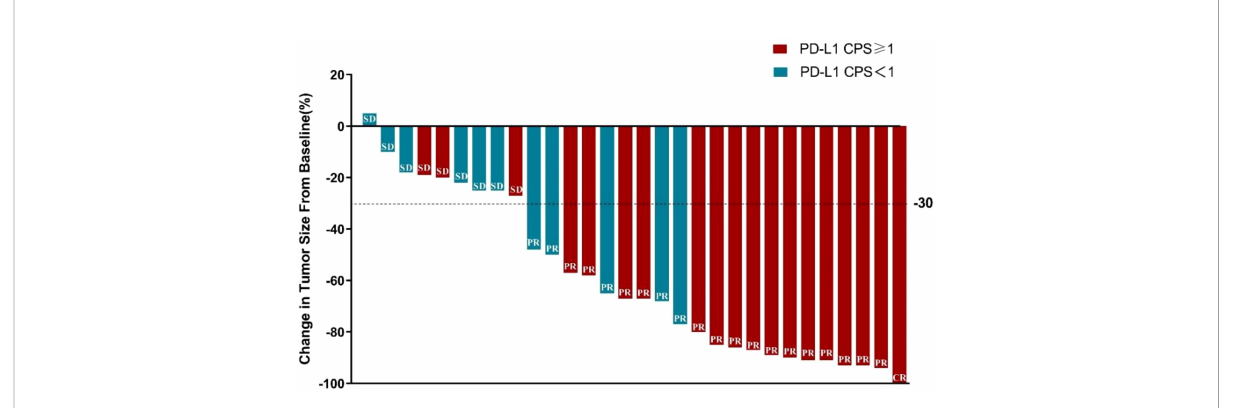
FIGURE 2 A waterfall plot of best ranked tumor reduction.